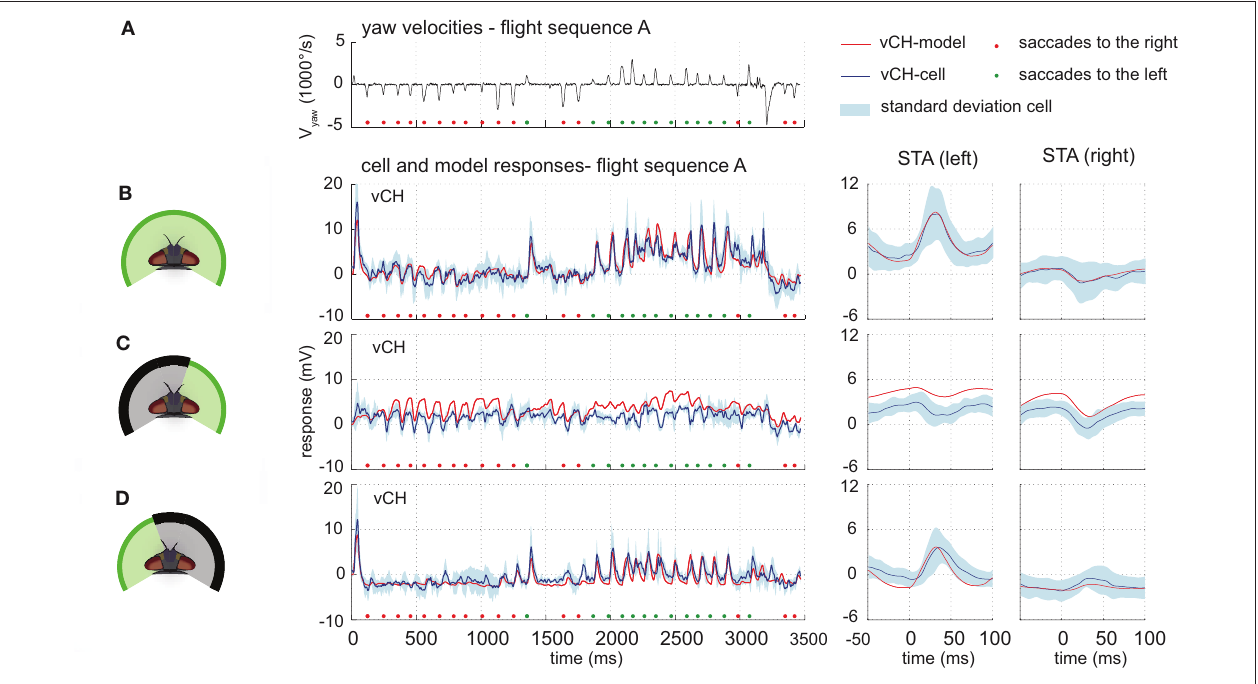
vCH (red) plotted against the time for flight sequence A during full stimulation. (C,D) Responses and STAs of right vCH-cell (blue) and model (red) to flight sequence A. The stimulus is limited to the right part (C) or the left part (D) of the visual field,